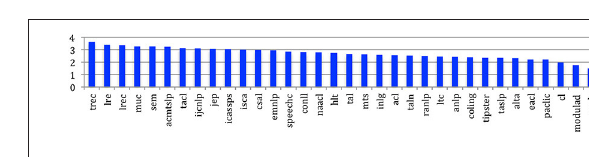
FIGURE 17 | Average number of authors per paper across the